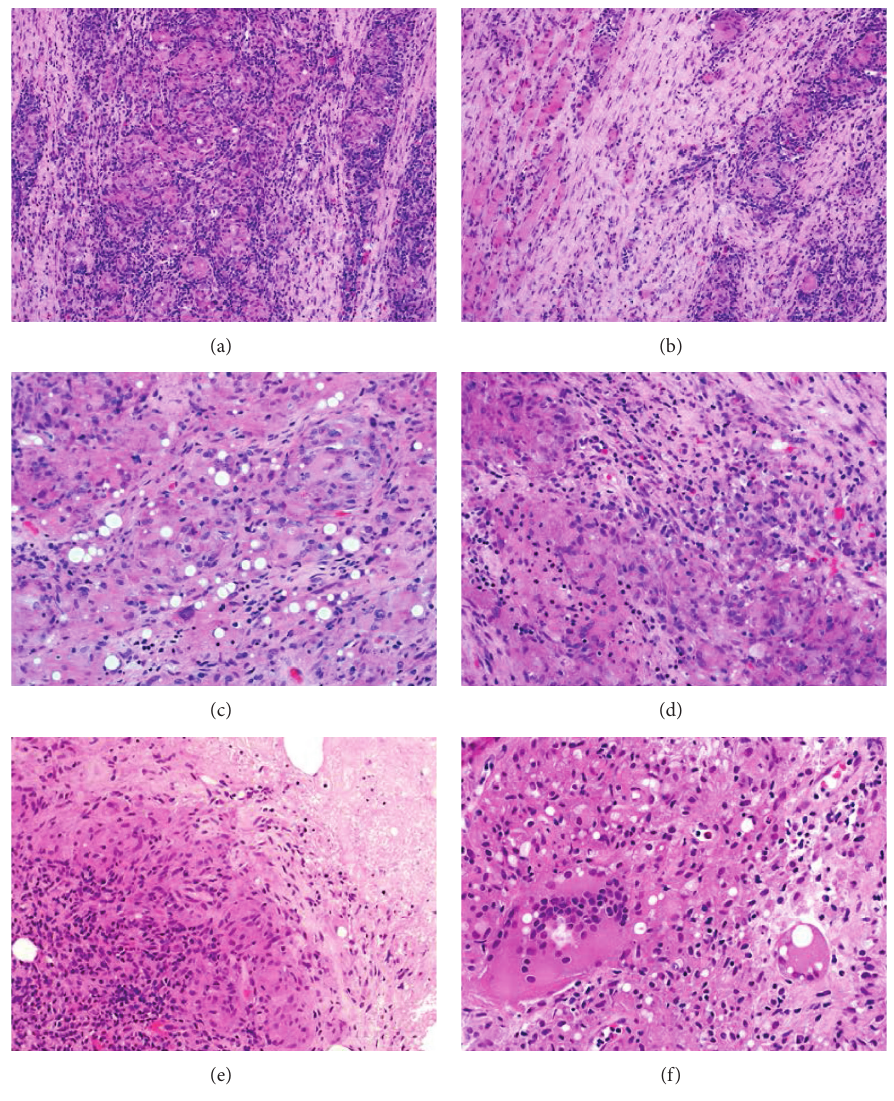
Figure 3: (a) These are relatively ill-defined granulomas comprising sheets of epithelioid histiocytes and giant cells and are surrounded by prominent mixed inflammation rich in small lymphocytes. (b) This example occurred deeply within the biceps muscle. There is atrophy of skeletal muscle fibers, with surrounding fibrosis and chronic inflammation. (c) In areas, there are rounded clear intracytoplasmic vacuoles within the histiocytic population. This is thought to represent foreign body reaction to polylactic acid. Luteinising hormone-releasing hormone (LHRH) has been shown to have lipolytic activity in vitro , and the degenerate lipid granules may induce foreign body granulomas. (d) The chronic inflammatory infiltrate comprises largely histiocytes and small lymphocytes, but there are smaller numbers of plasma cells and eosinophils. (e) This example shows areas of necrosis. (f) The giant cells can contain twenty or thirty nuclei. Engulfment of vacuoles corresponding to degenerate elements of leuprorelin acetate is